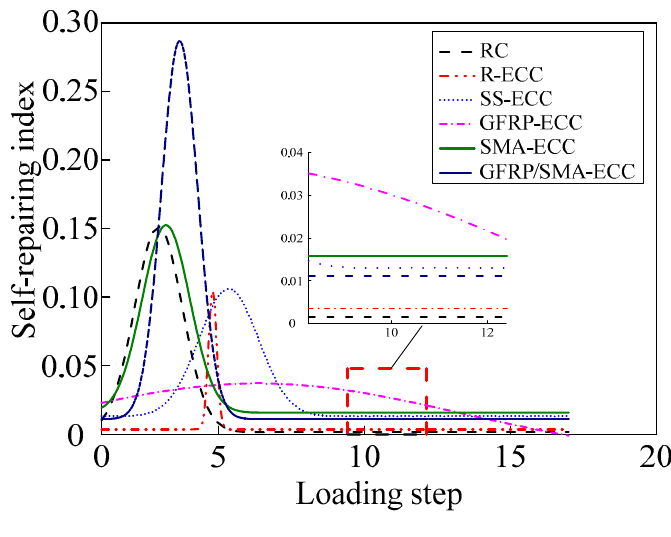
Figure 15. Self-repairing